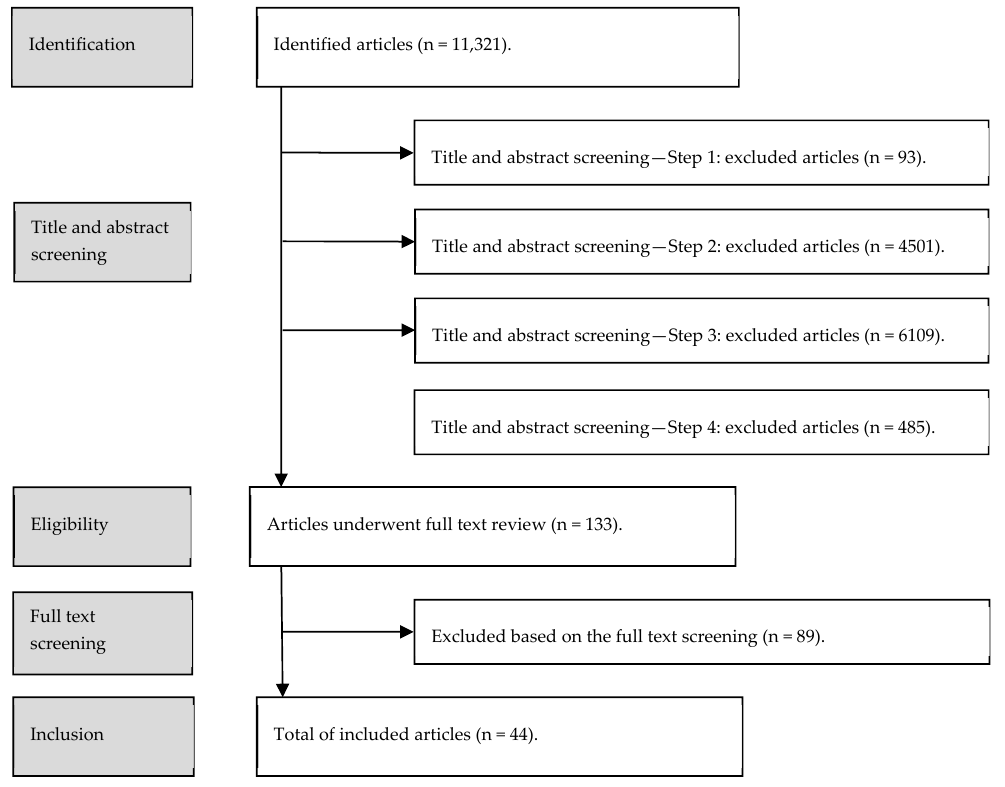
Figure 1. Flowchart of the systematic review.